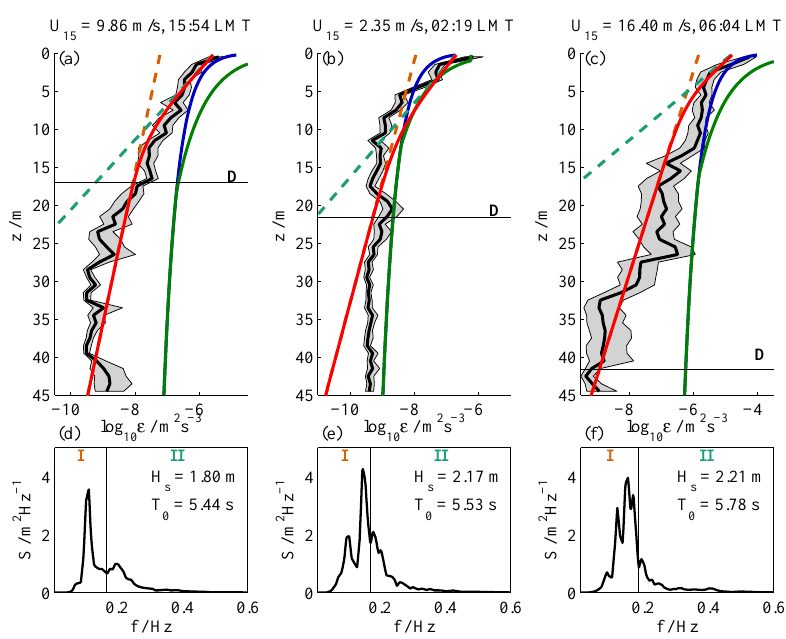
Fig. 10. Profiles of turbulent kinetic energy dissipation (a–c) for a particular wave spectra (d–f) . Five successive profiles of (cid:15) taken over one hour are averaged vertically into 1m bins with the solid black line showing the mean and the grey shaded region the 95% confidence intervals determined using a bootstrap method. The depth dependence of (cid:15) is compared with Eq. (5) (blue line), scaling of Terray et al. (1996) (green line), and the wave scaling of Huang and Qiao (2010) (red line) using portions of the wave spectra along with Eq. (6) (dashed lines with colours matching the corresponding spectral region marked by I, and II in d–f ). The red line denotes the sum of the wave scaling turbulence profiles from section I and II, i.e. the dashed orange line plus the dashed green line. The values of H s and T 0 for each wave spectra are computed for the entire spectra. The mixed layer depth is the black horizontal line denoted by D .